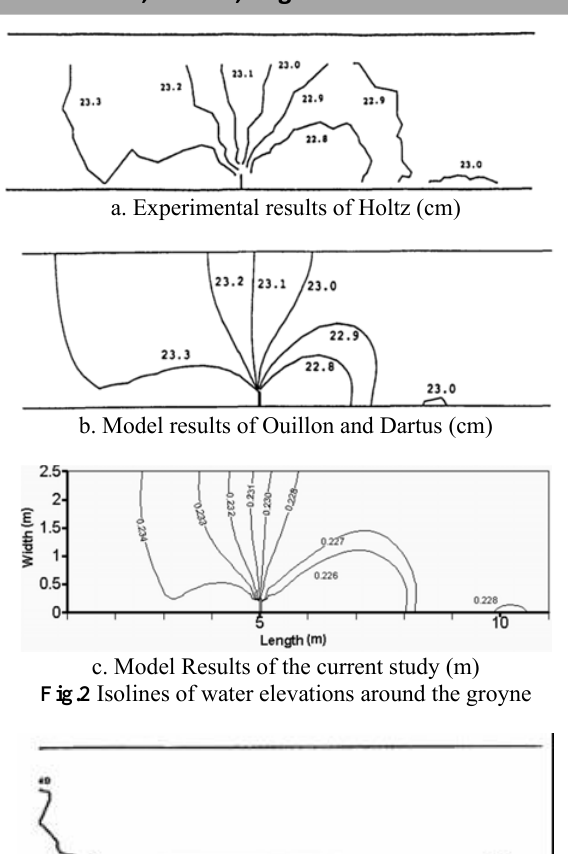
Fig.4 Isolines of velocity around the groyne at